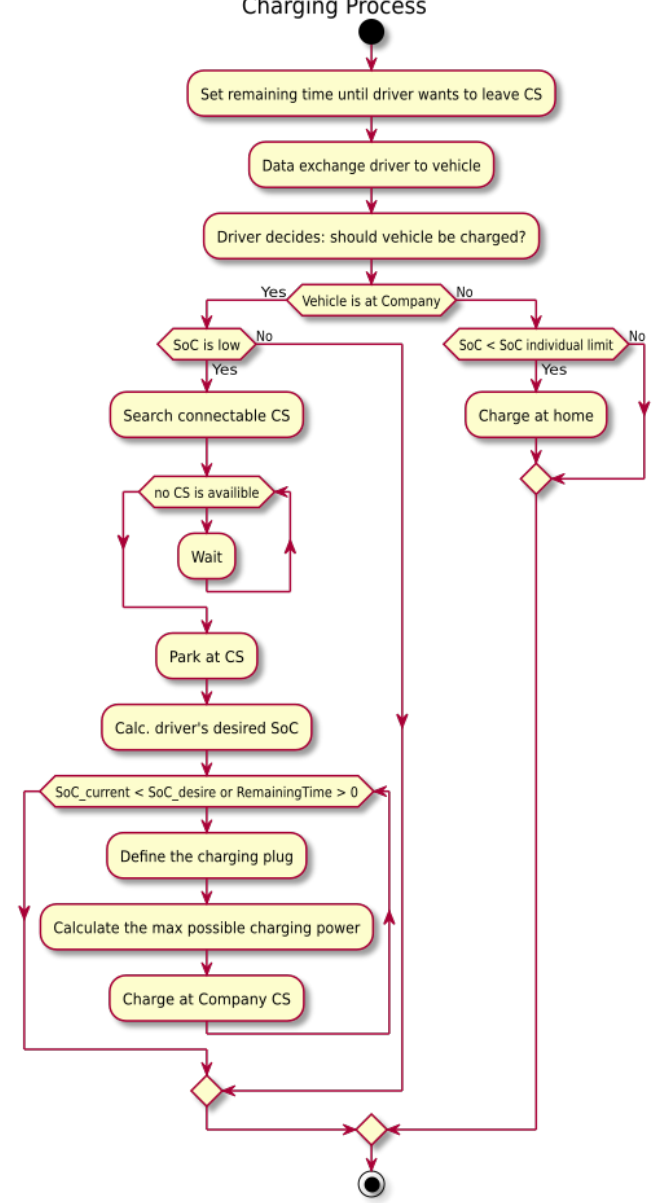
Figure 2. Modeling of the charging process in the